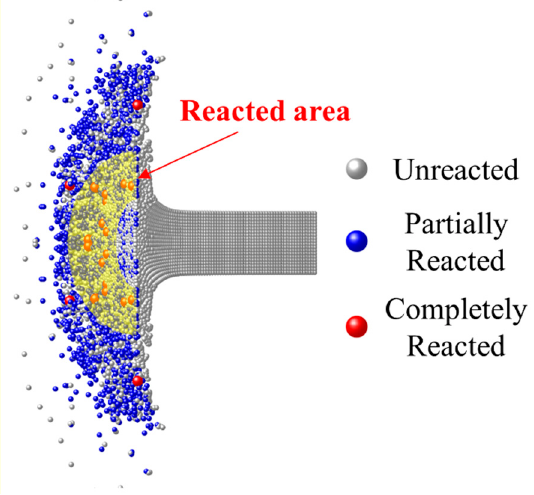
Figure 11. Calculated result (cross-section view with a rotation angle of 30°) at 775 m/s impact velocity and 30 μ s (corresponding to the experimental result of the same loading conditions in Figure 4a of Ref. [8]).